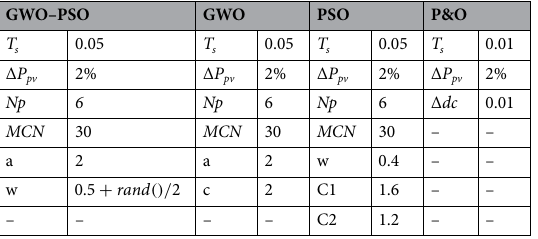
Table 3. Parameters of GWO–PSO, GWO, PSO, and P&O based MPPT methods.